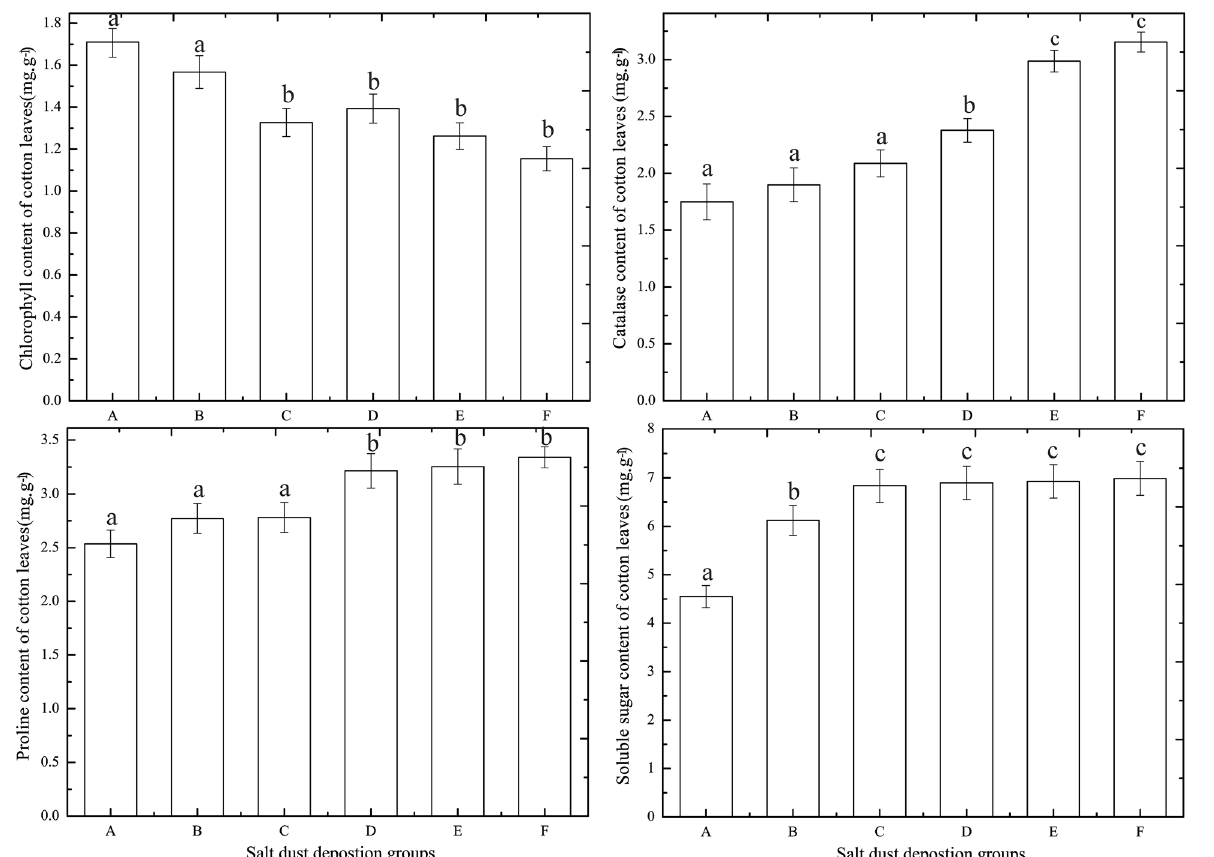
Fig 11. Changes in quantities of chlorophyll, carotenoids, soluble sugars and proline in the cotton leaves.